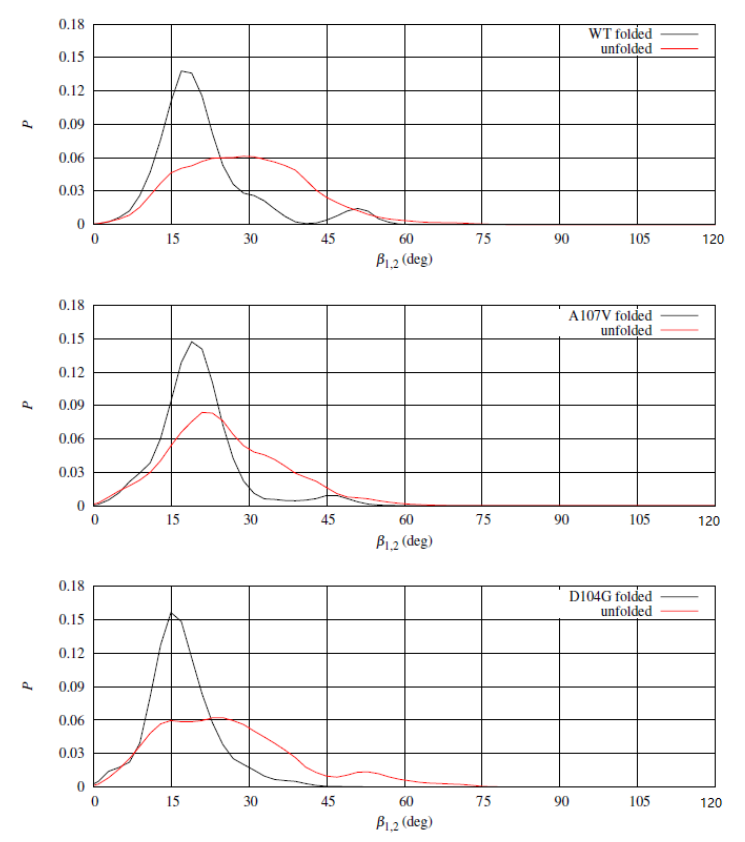
Figure 10. Distribution of the angle between long axes of α 1 and α 2 segments ( β 1,2 ) in folded (CV = 14, black curve) and unfolded (CV = 4, red curve) states. Top—WT sequence; middle—A107V variant; bottom—D104G